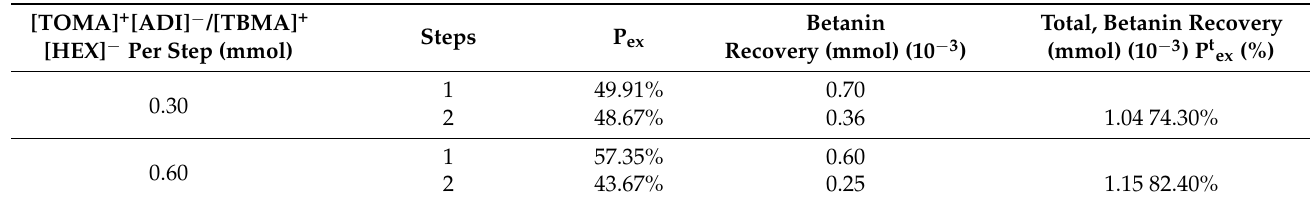
Table 2. Recovery percentages of betanin (initial 1.40 × 10 − 3 mmol) after two steps.